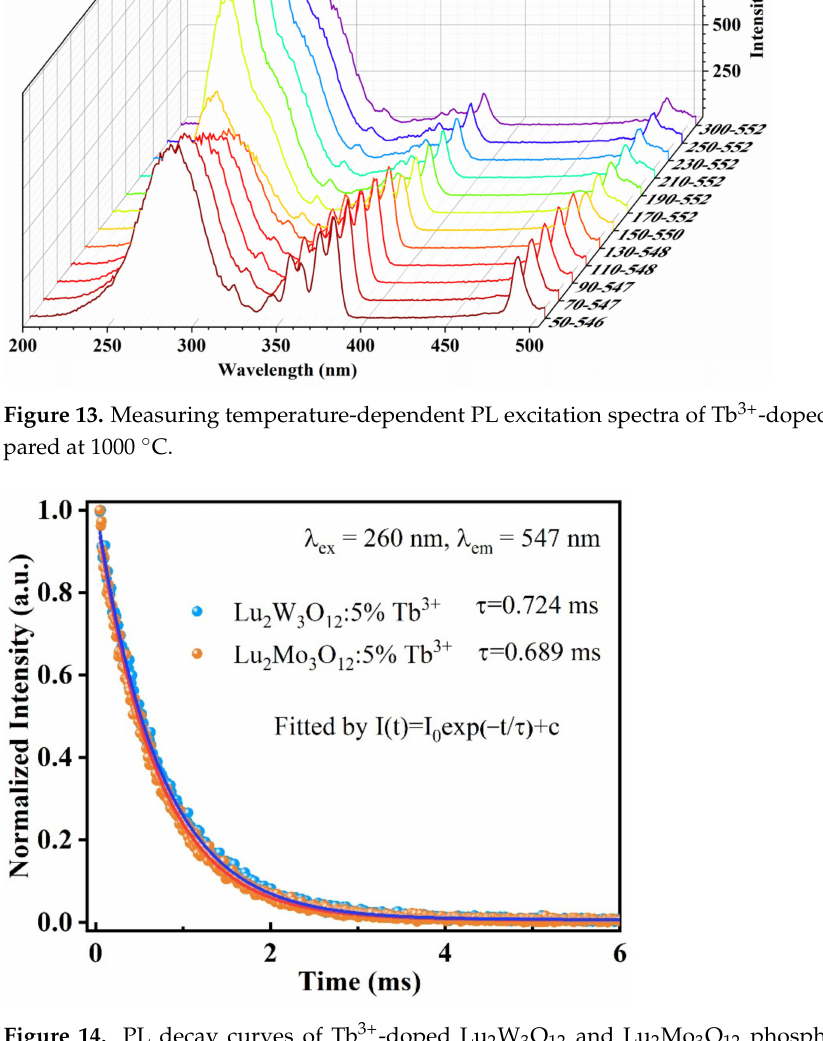
Figure 14. PL decay curves of Tb 3+ -doped Lu 2 W 3 O 12 and Lu 2 Mo 3 O 12 phosphors prepared at 1000 ◦